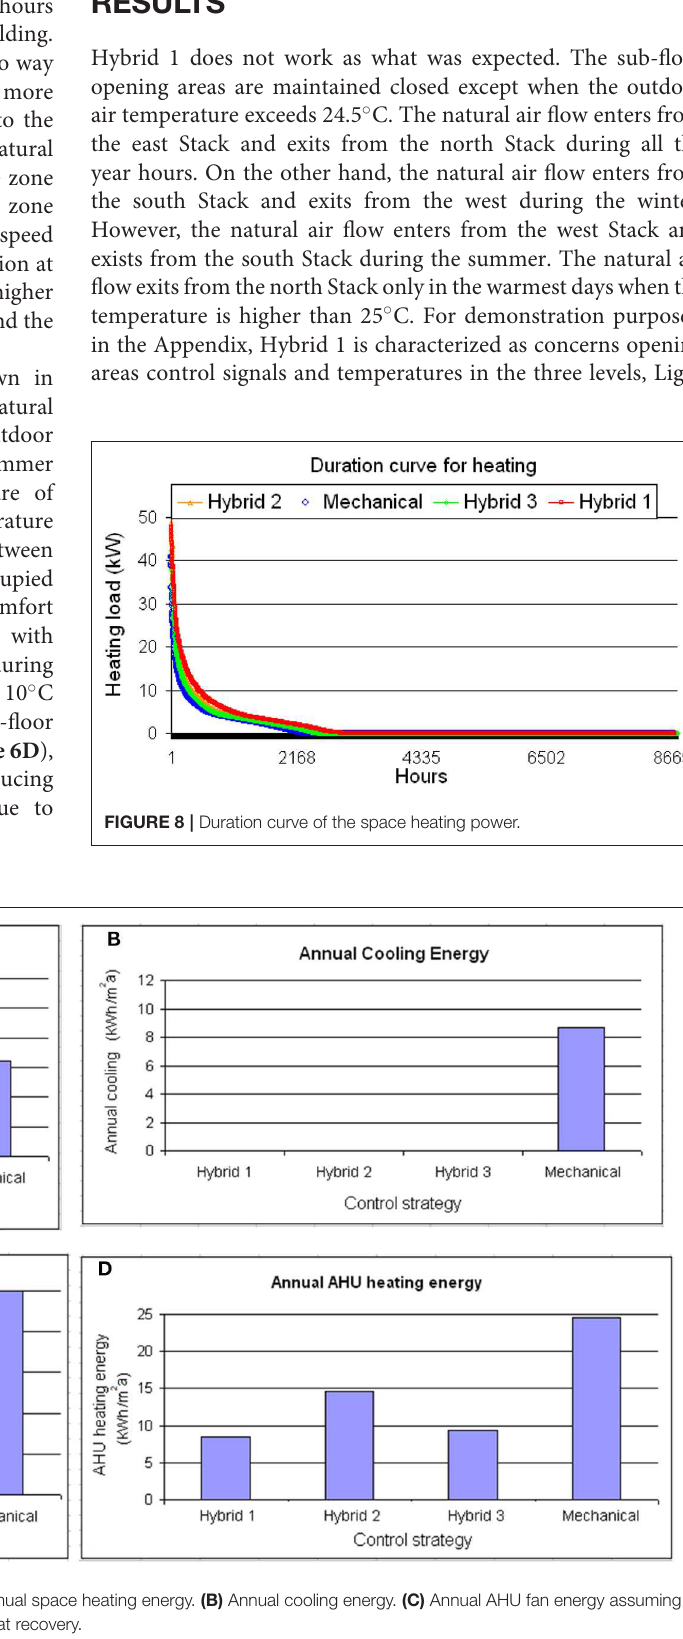
Frontiers in Built Environment |